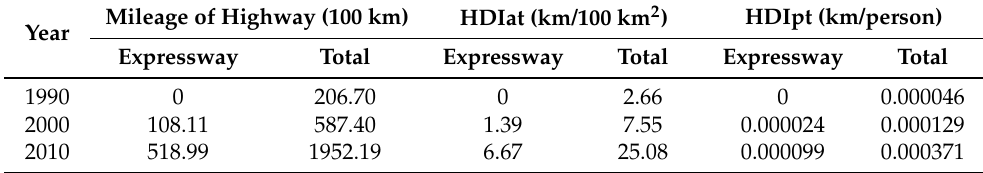
Table 2. Highway density between 1990 and 2010 for the Hang-Jia-Hu Plain